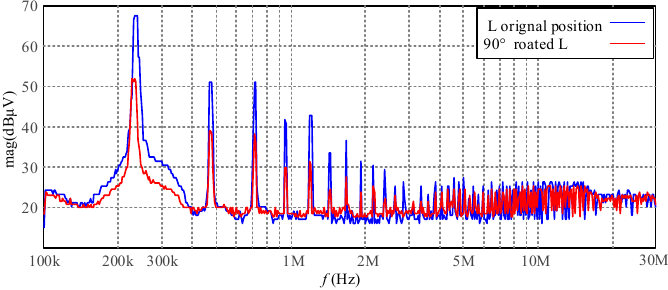
Figure 5. CM emission curves when L is rotated or not.